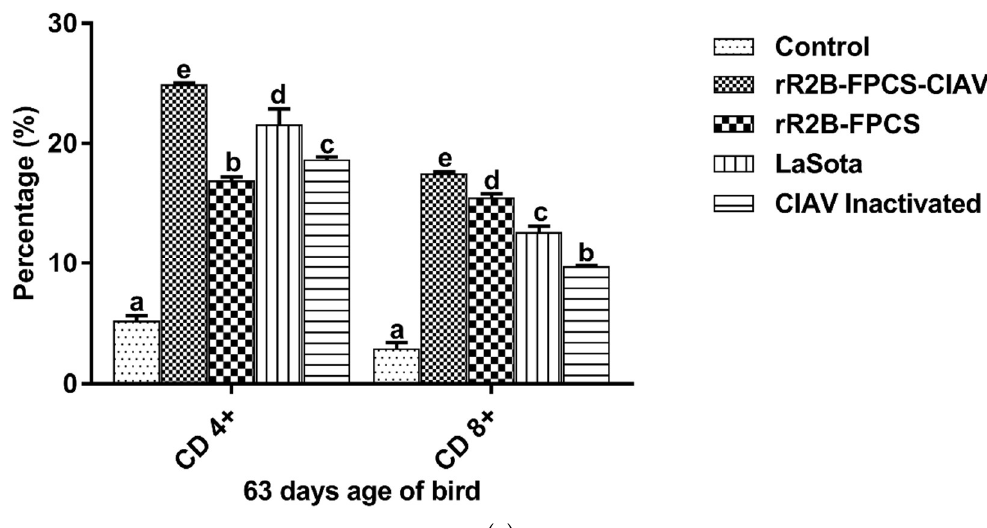
Figure 6. Assessment of ( a ) NDV recombinant NP antigen and ( b ) recombinant CIAV antigen expressed in Saccharomyces cerevisiae specific, lymphocyte proliferation response in chicken at 21, 35, 49, 63 and 77 days of age. The PBMCs from the experimental birds ( n = 10) were stimulated and antigen specific lymphocyte proliferation was expressed as stimulation index (mean ± SE). Different capital letter superscripts indicate the time effect ( p < 0.0001) while small letter superscripts indicate the treatment effect ( p < 0.0001); ( c ) at 35 days of age and ( d ) at 63 days of age vaccination induced mRNA level of cytokine genes was measured by quantitative real-time PCR with normalization to GAPDH gene and relative fold change determination by the 2 −ΔΔct method. Relative fold change of cytokine gene transcripts is presented. Data are presented as mean value ± standard error and different small letter superscripts indicate the treatment effect ( p < 0.0001). Flow cytometric analysis for CD4 + and CD8 + T cell subsets in different vaccinated groups. Percentage of CD4 + and CD8 + T cells in PBMCs at ( e ) 21 days, ( f ) 35 days and ( g ) 63 days of age of birds in different groups. Bars (mean ± SE) indicate the representative data of a single experiment and data with different small letter superscripts indicate the treatment effect ( p < 0.0001).